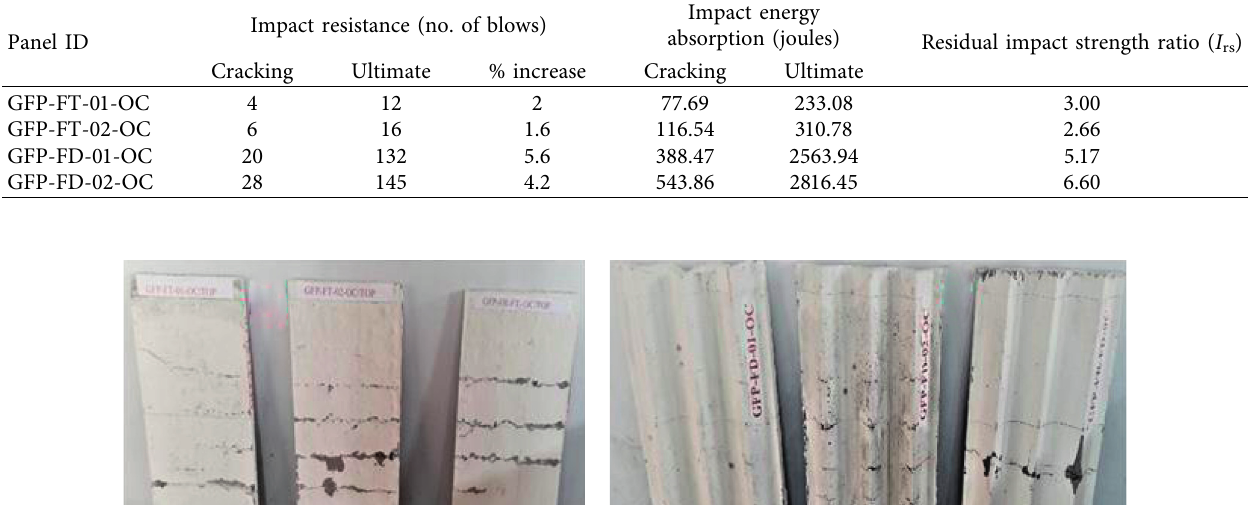
Table 5: Impact resistance, impact energy absorption, and residual impact strength of GF panels. Panel ID